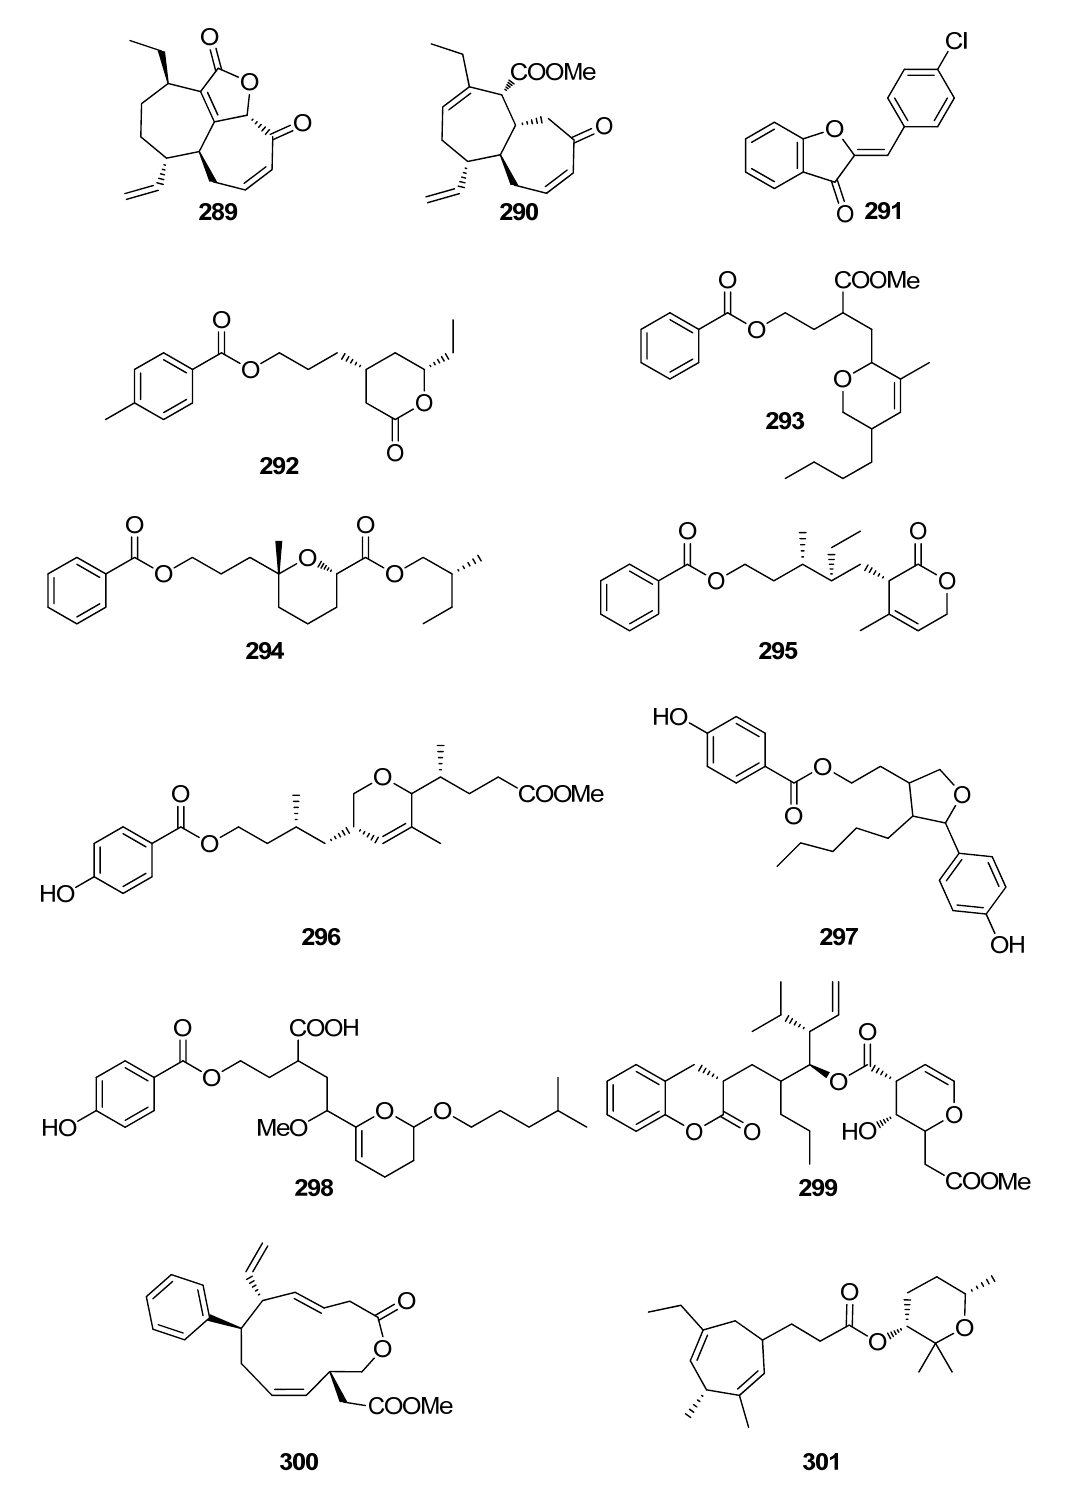
Figure 24. Chemical structures of compounds 289 – 301 .